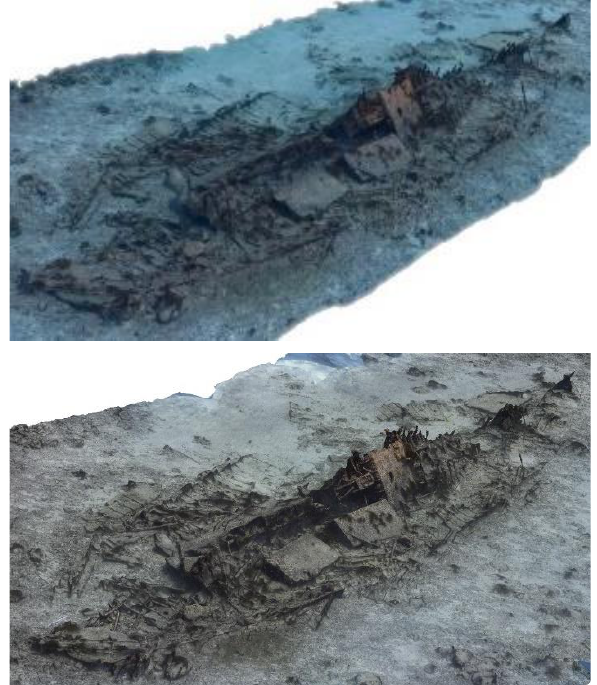
Figure 13. 3D model (triangulated mesh) of the Mandalay texturized without using white balancing (top) and after the radiometric correction